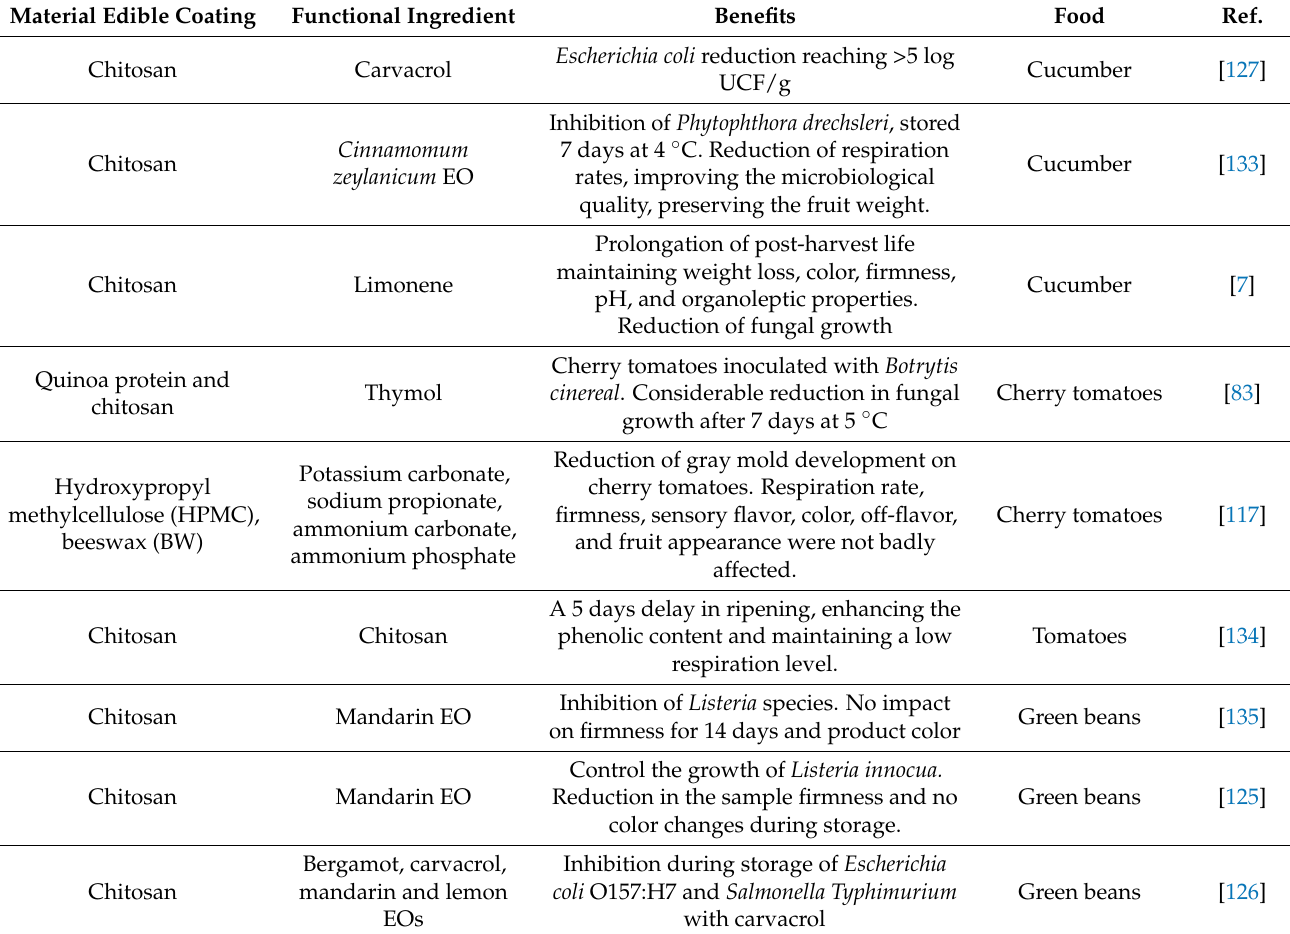
Table 3. Active coatings based on polysaccharide fro fresh and minimally processed vegetables and fresh-cut fruit. Material Edible Coating Functional Ingredient Benefits Food